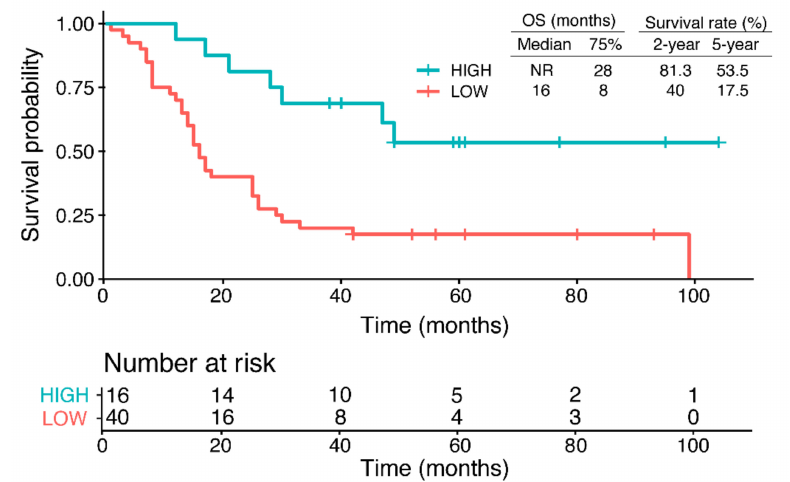
Figure 2. Overall survival (OS) according to the expression levels of RPRML in GC. Kaplan–Meier curves show the OS probability of patients with high versus low RPRML expression (cut-o ff IHC score = 0.162) among 56 advanced GC cases (TNM Stage III and IV). The median and 75% percentile OS times and 2- and 5-year survival rates are shown. The bottom panel shows the number of patients at